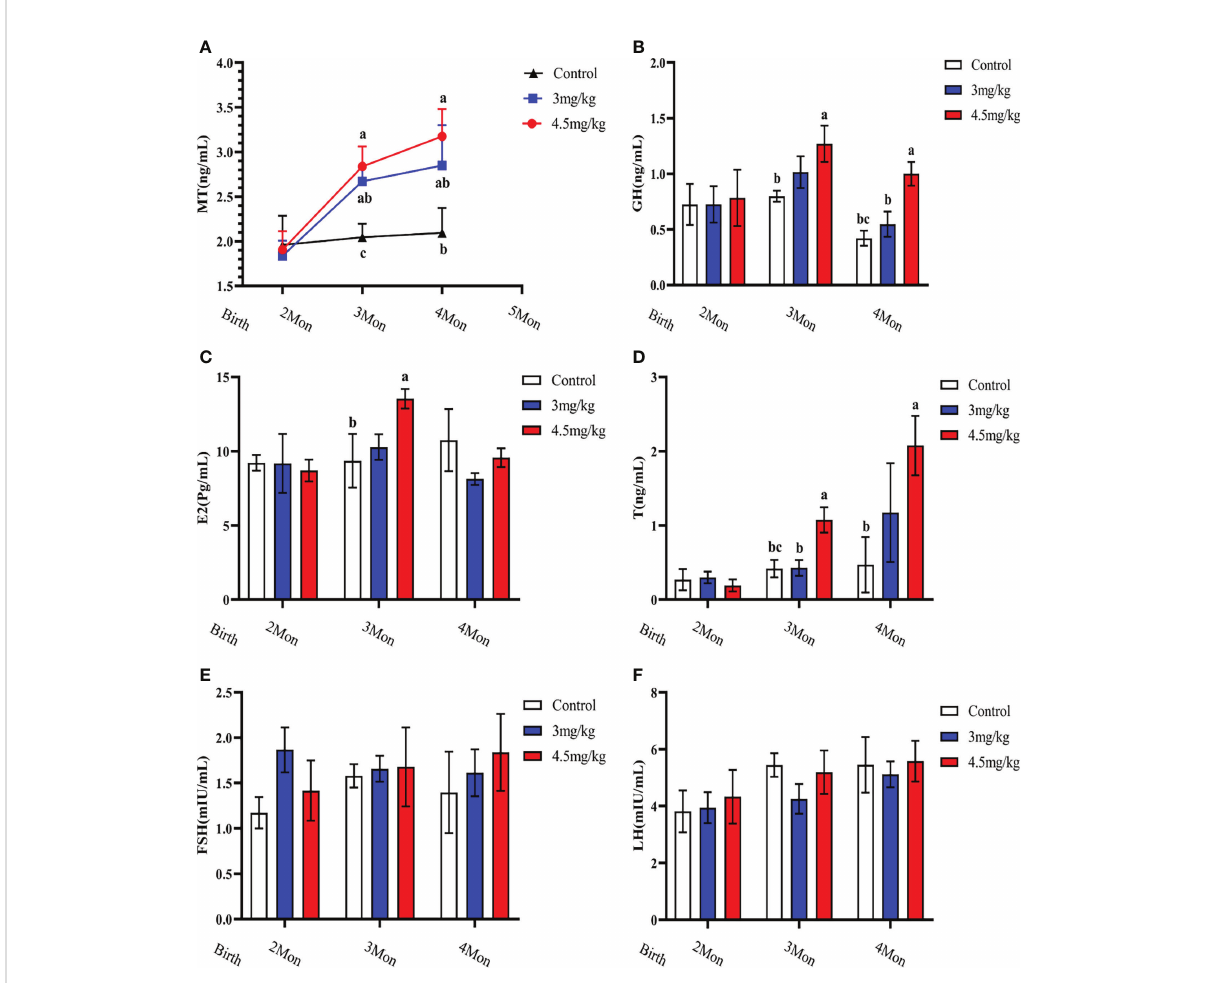
FIGURE 2 Effects of melatonin on blood melatonin levels and reproductive hormones in lambs. (A) Melatonin levels; (B) Growth hormone; (C) Estradiol; (D) Androgens; (E) Follicle-stimulating hormone; (F) Luteinizing hormone-releasing hormone. Note: Different lowercase letters indicate P <0.05 vs